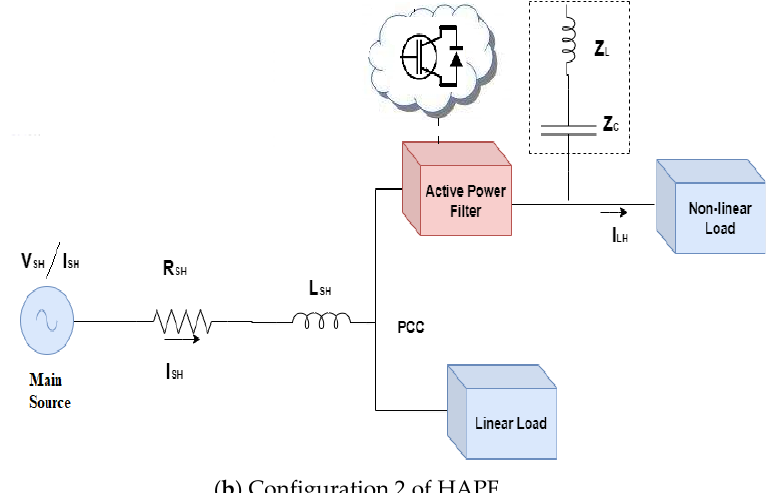
Figure 2. The main circuit of configurations 1 and 2 of HAPF.